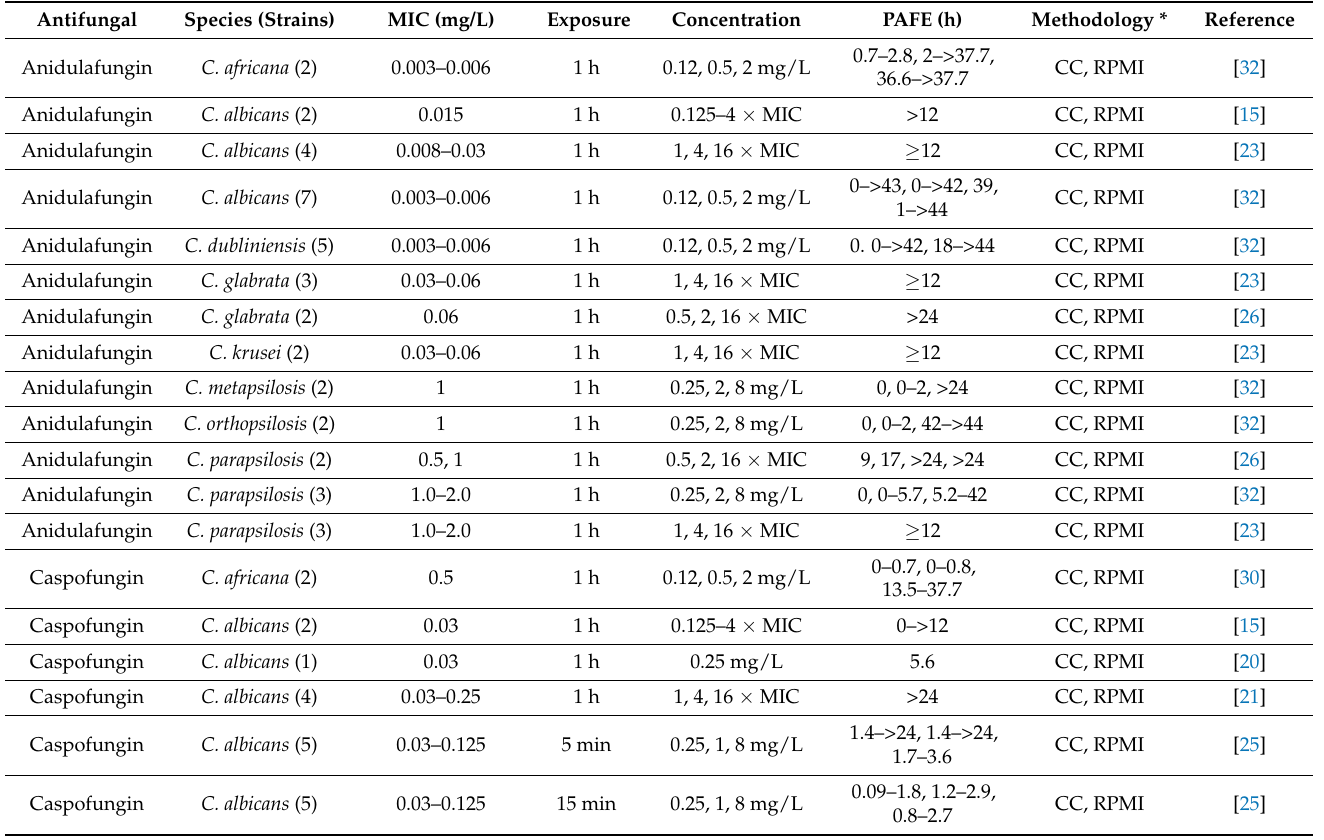
Table 3. PAFE in vitro of